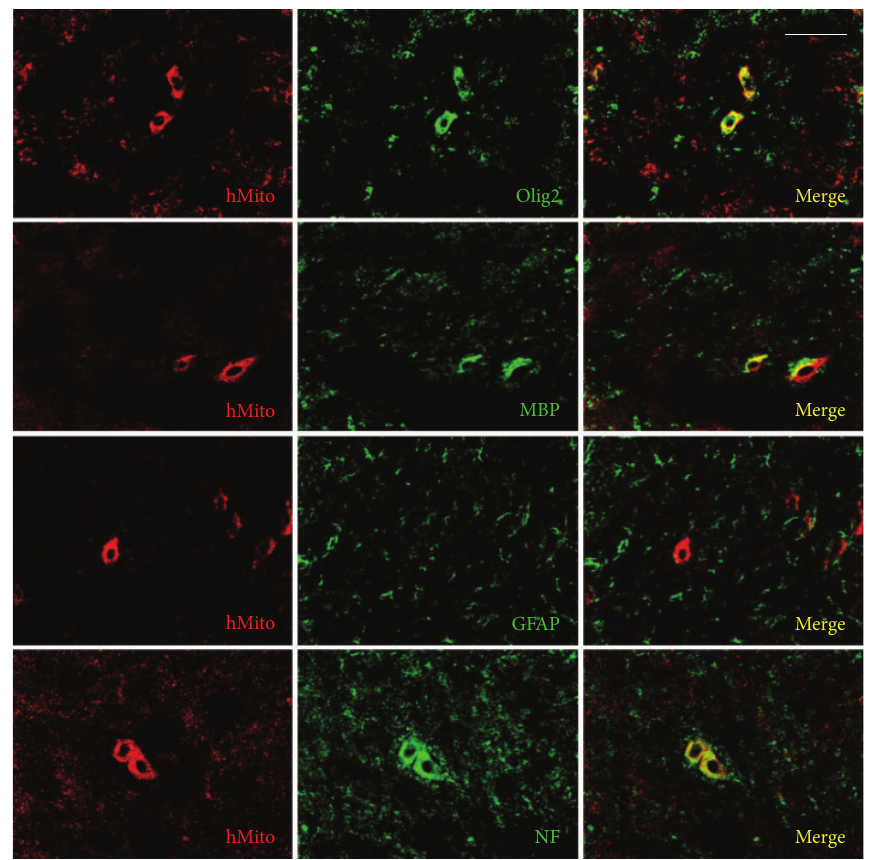
Figure 5: Differentiation of transplanted human (hMito-positive)F3 cells into oligodendrocytes (Olig2-positive), astrocytes (GFAP-positive), or neurons (NF-positive) and maturation to MBP-positive oligodendrocytes. Olig2: oligodendrocyte transcription factor, MBP: myelin basic proteins, GFAP: glial fibrillary acidic proteins, and NF: neurofilaments. Bar = 25 𝜇